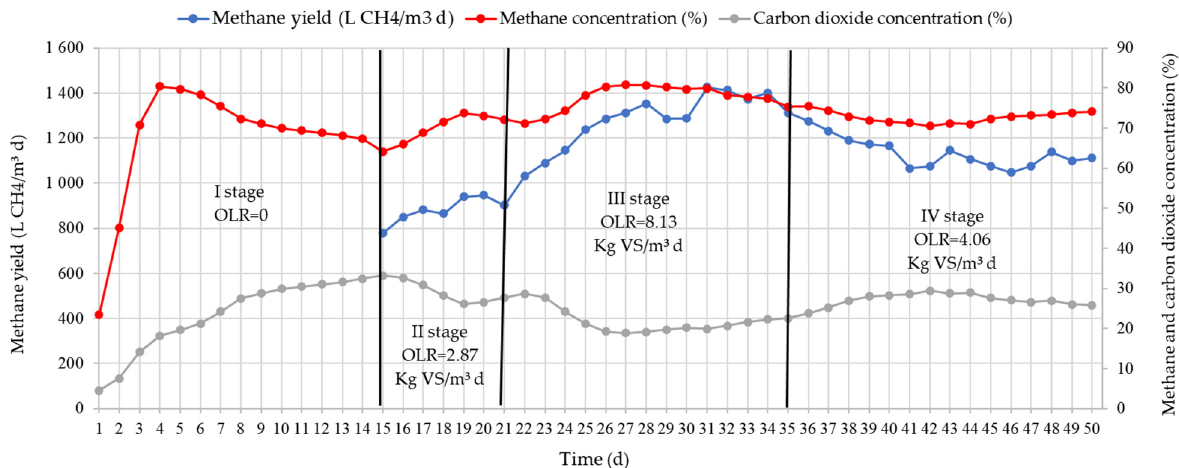
Figure 4. Levels of methane (CH 4 ) yield and carbon dioxide (CO 2 ) concentration in TSB at different OLRs.